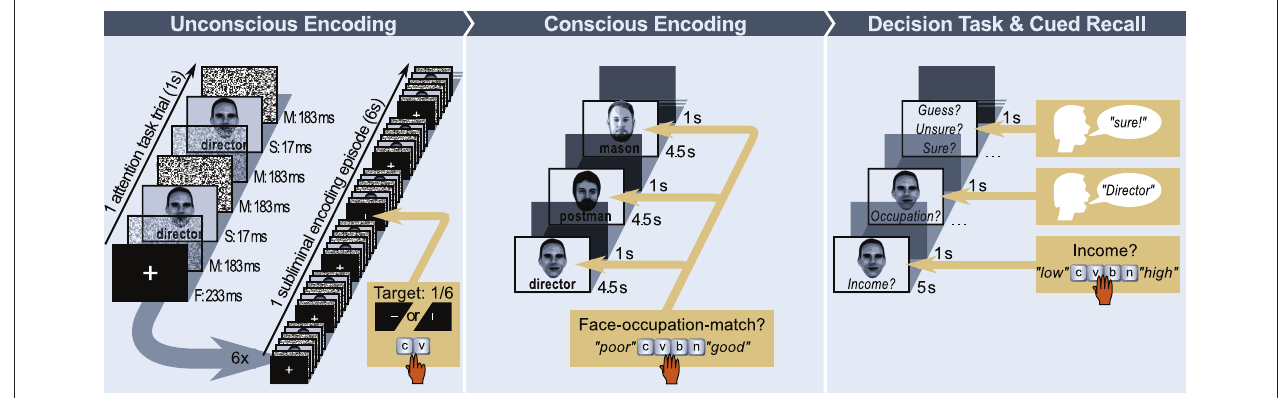
FIGURE 2 | Schematic illustration of experimental tasks. Unconscious Encoding: One subliminal encoding episode in which one subliminal stimulus (S: face with occupation word) is presented 12 times in between masks (M). One encoding episode consists of 6 attention task trials. In one of these trials, the fixation screen (F) contains a target stimulus (“ − ” or “|” instead of “ + ”); Conscious Encoding: Sequence of three supraliminal encoding trials. Participants indicated by button press how well the indicated occupation matched a person ([C]: “poor,” [V]: “poor-average,” [B]: “good-average,” or [V]: “good” match); Decision Task and Cued Recall: Participants first decided on the suspected income of the person ([C]: “low,” [V]: “low-average,” [B]: “high-average,” or [V]: “high” income), then tried to remember and say the occupation associated to this face, and finally indicated whether they randomly guessed, had a hunch but were unsure, or certainly remembered the occupation; The individuals depicted in this figure gave written informed consent to publication of their